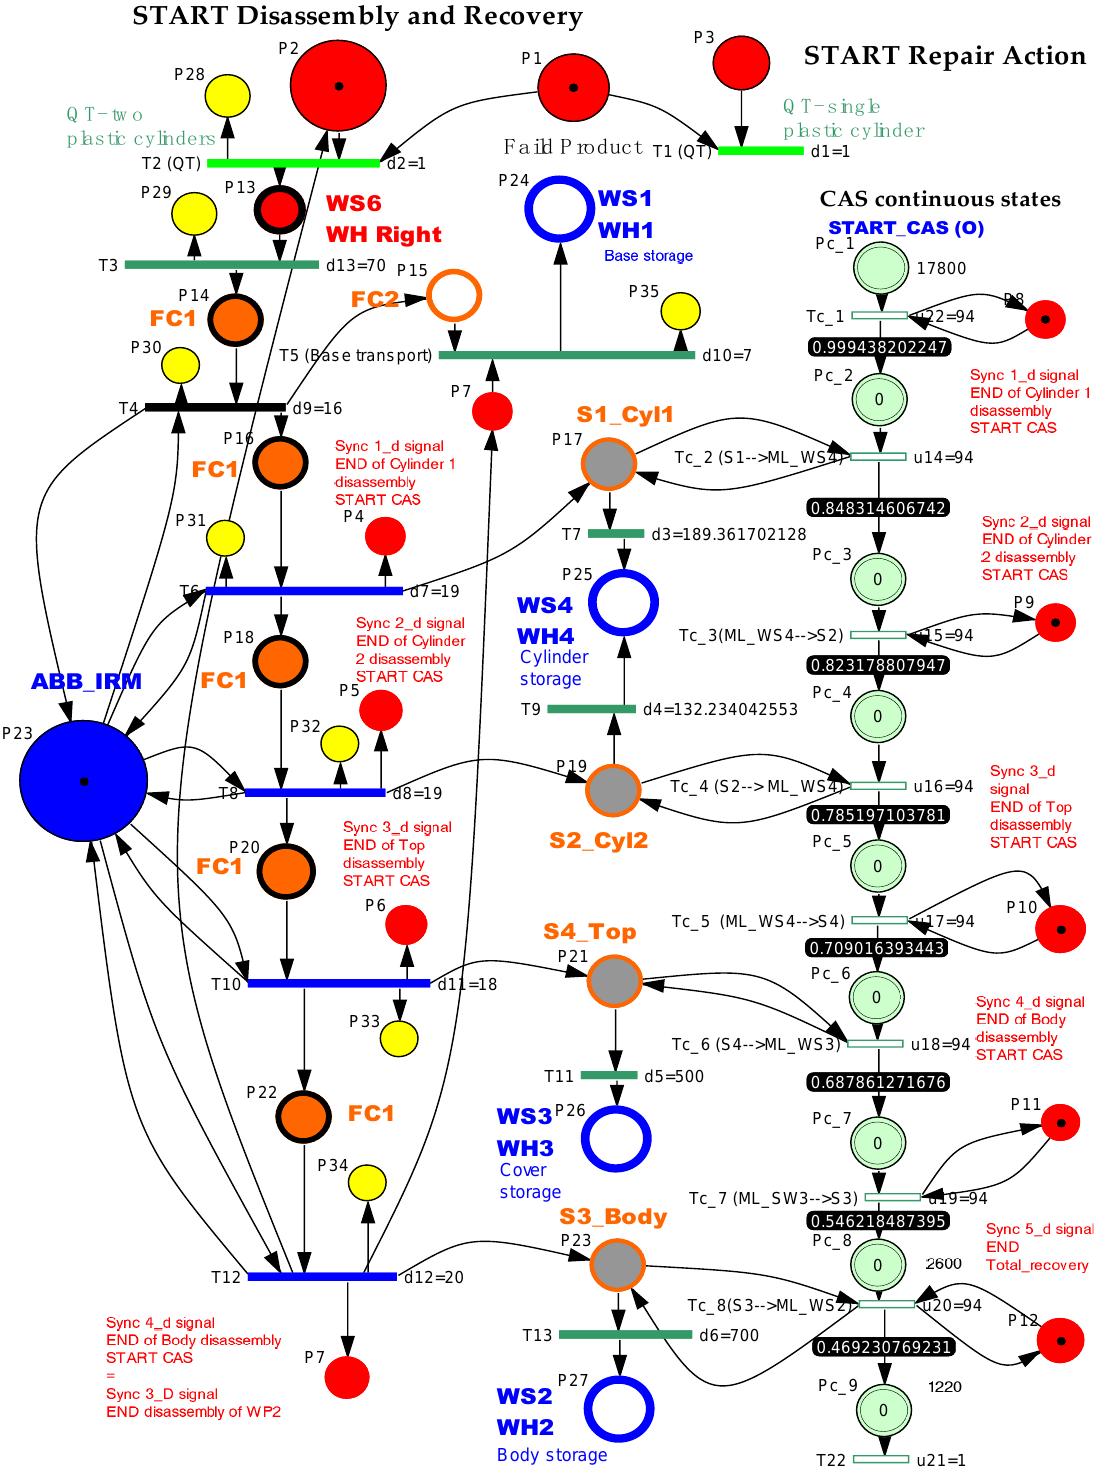
Figure 11. The SHPN_1 model for the disassembly of the WP2 on FC with ABB IRM.